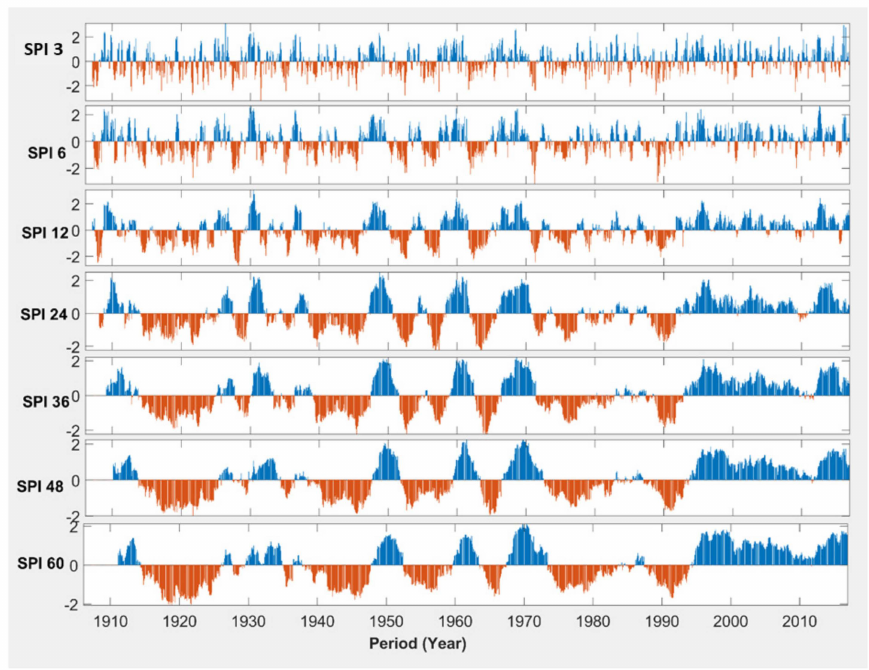
Figure 7. Time series plot of the Standardized Precipitation Index (SPI)-x evaluated by di ff erent time windows from 3 to 60